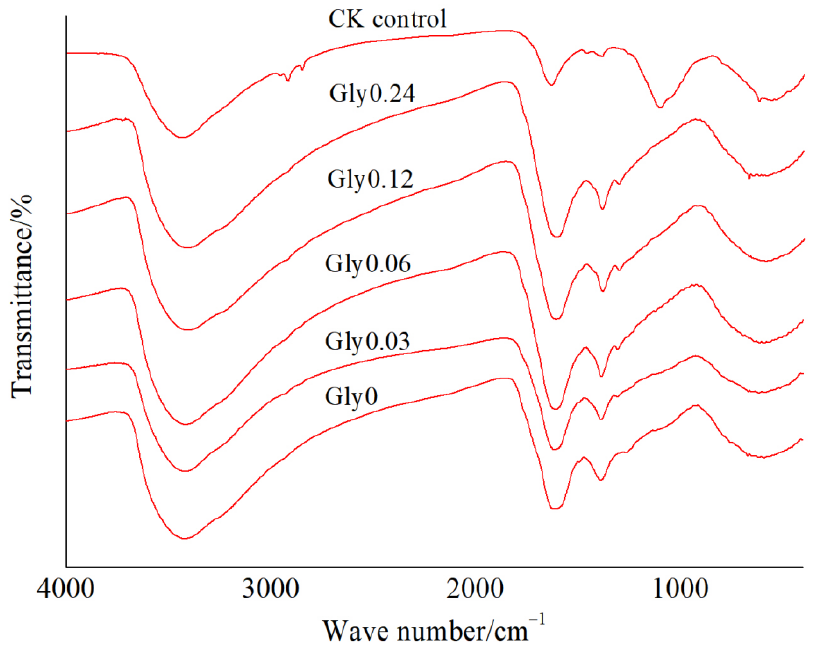
Figure 5. Effects of the glycine with different concentrations in the Maillard precursors on the FTIR spectra of the dark-brown residue.